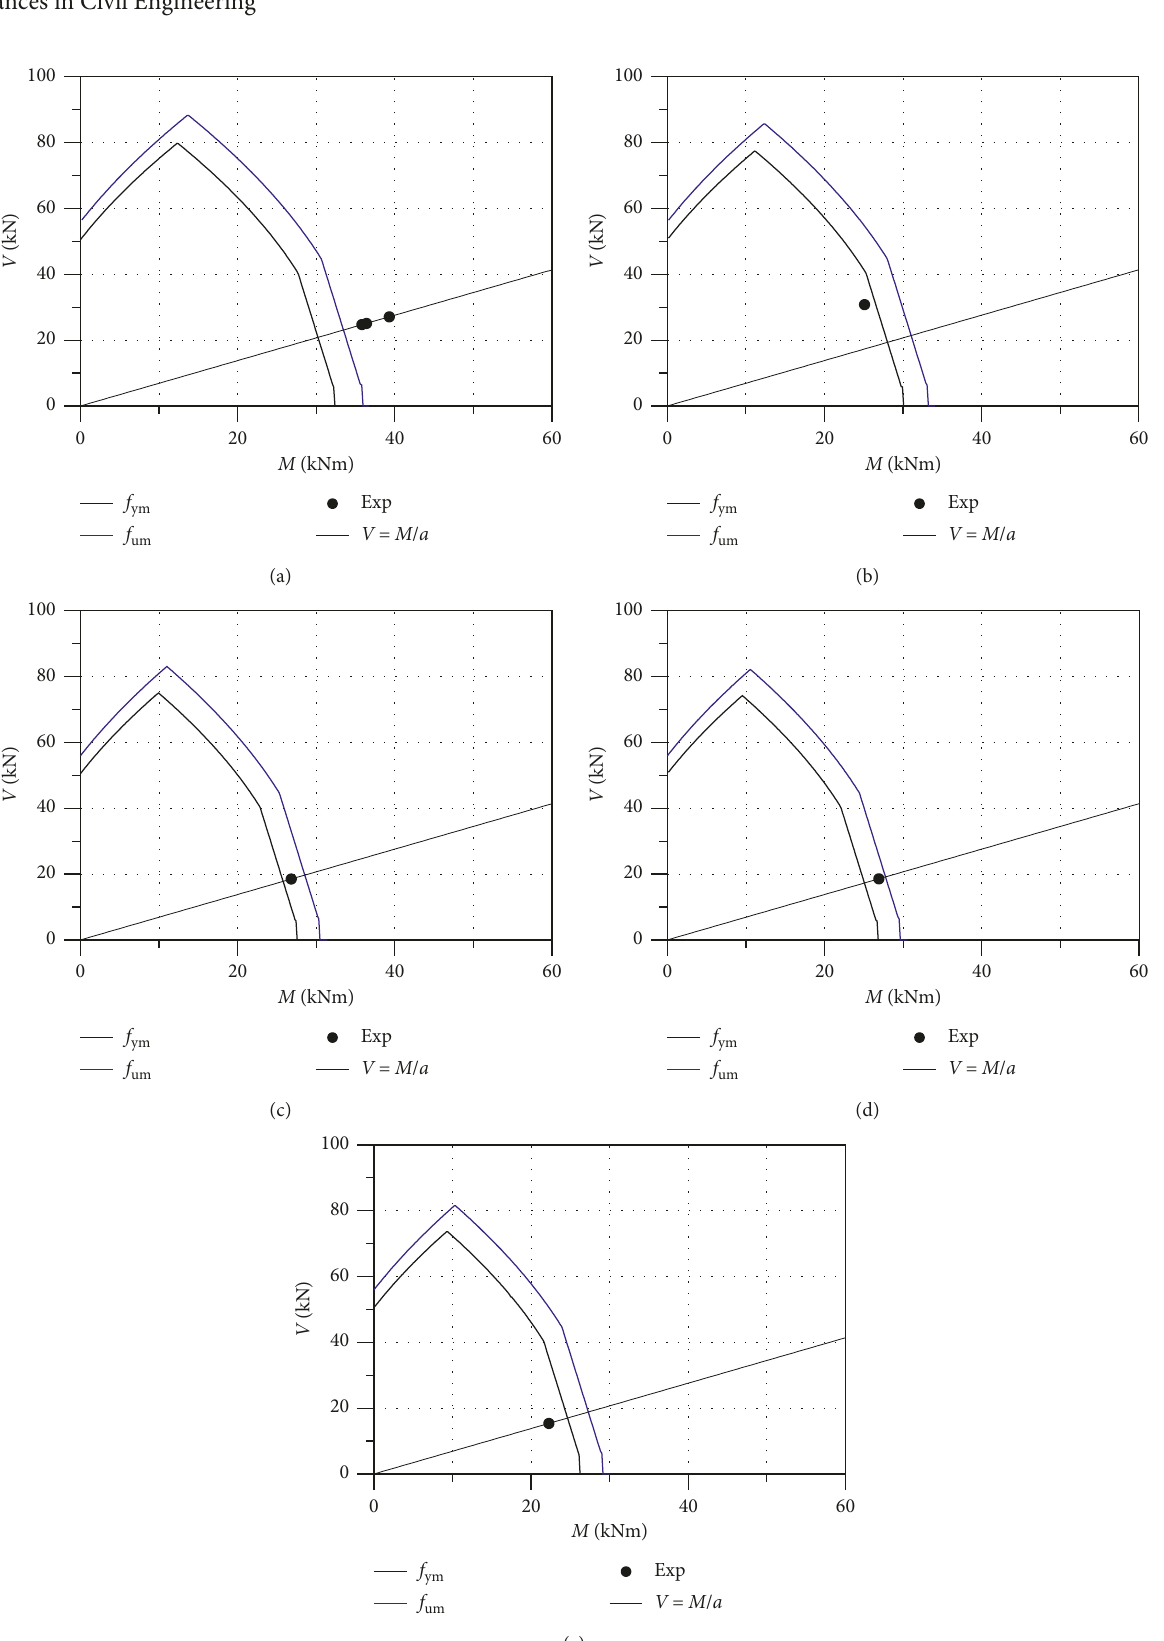
Figure 6: Interaction diagrams M - V for all specimens tested by Zhu and François [8]. (a) B1T, (b) B1Cl1, (c) B2Cl1, (d) B2Cl2, and (e)